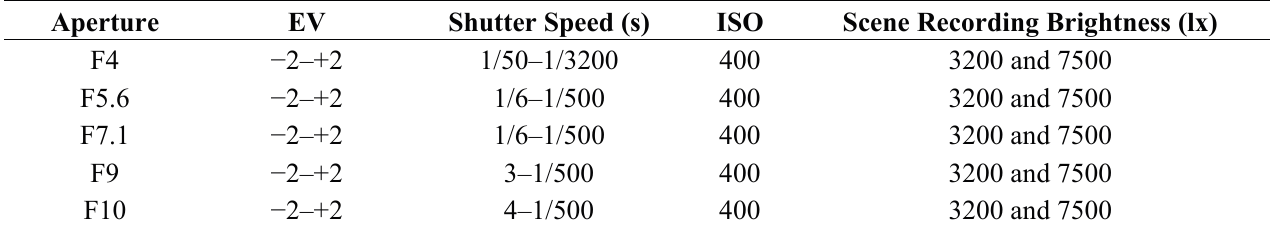
Table 1. Detailed environmental and hardware parameters.